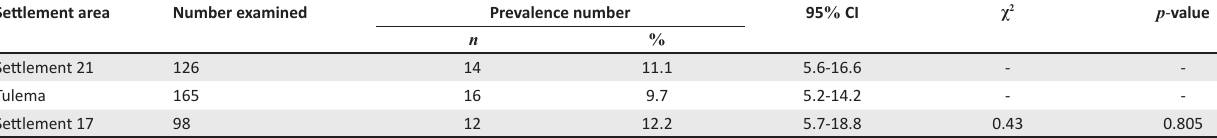
TABLE 3: Occurrence of trypanosome infection in cattle in settlement areas of Hawa-Gelan district. Settlement area